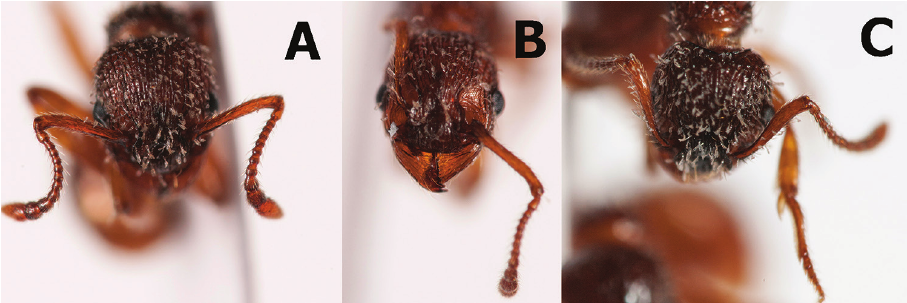
Figure 1. Appearance of the fungal infection on mounted specimens: Rickia -infected Myrmica scabrinodis hosts killed by freezing ( A ) or with ethanol ( B ) or chloroform ( C ), photographed one month after mount- ing and dry storage.